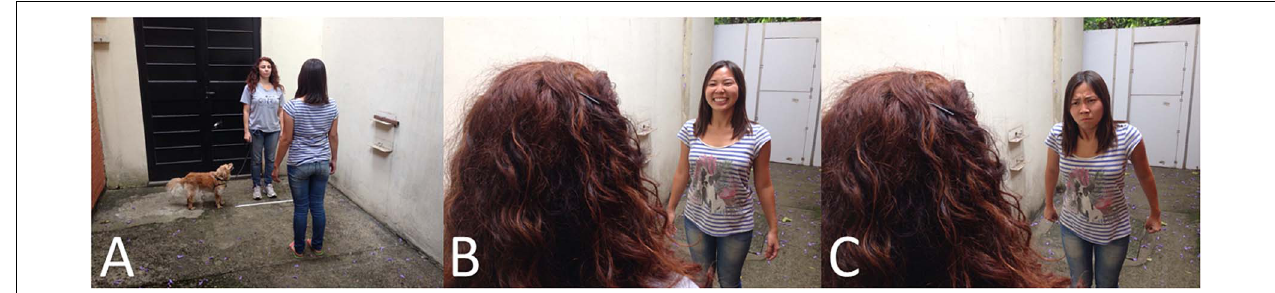
FIGURE 3 | Example of the emotional display phase. (A) Shows where the owner was positioned, (B) depicts a positive emotional display, and (C) depicts a negative emotional